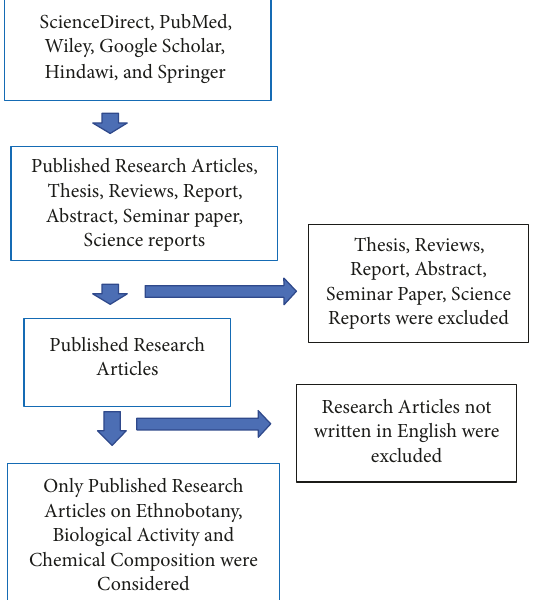
Figure 1: Flowchart of the